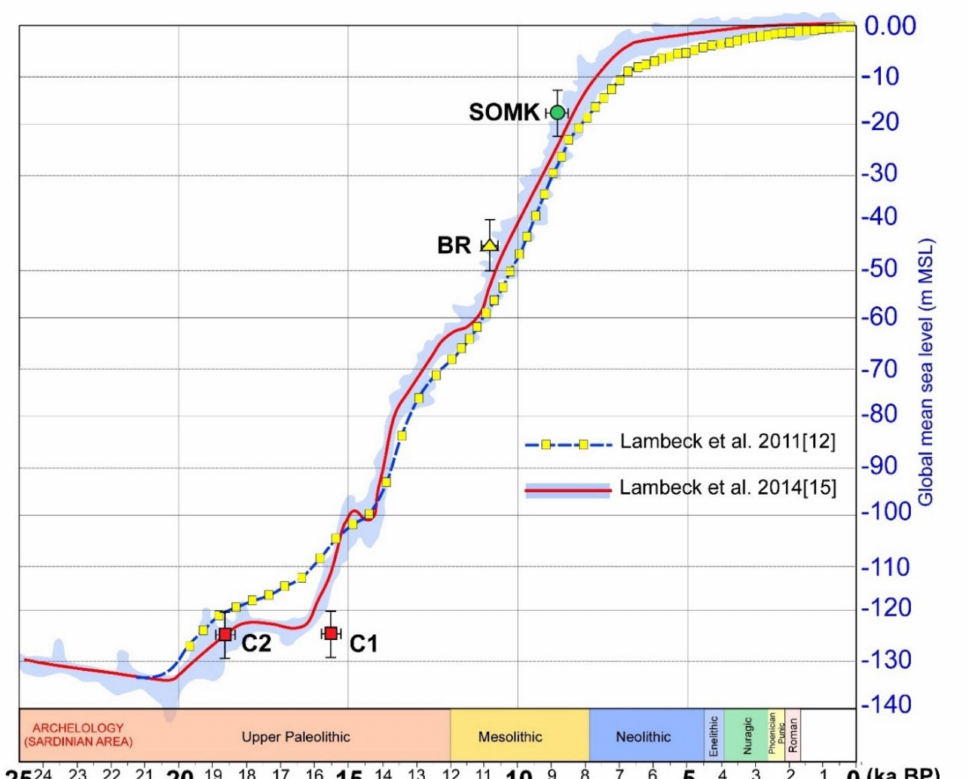
Figure 16. Relative sea-level prediction curve after Lambeck et al., 2011 [12] and Lambeck et al., 2014 [15], associated with palaeo-sea-levels indicators of San Pietro continental shelf: lagunar shells, (C1) Acmea virginea (gasteropoda)—18,982 ± 338; (C2) Mytilus galloprovincialis (Bivalvia)—15,350 ± 338 yr cal BP; BR) beachrock—10,835 ± 170 ky cal BP (De Muro and Orr ù , 1998 [51]); SOMK) Mesolithic site (Melis and Mussi, 2016